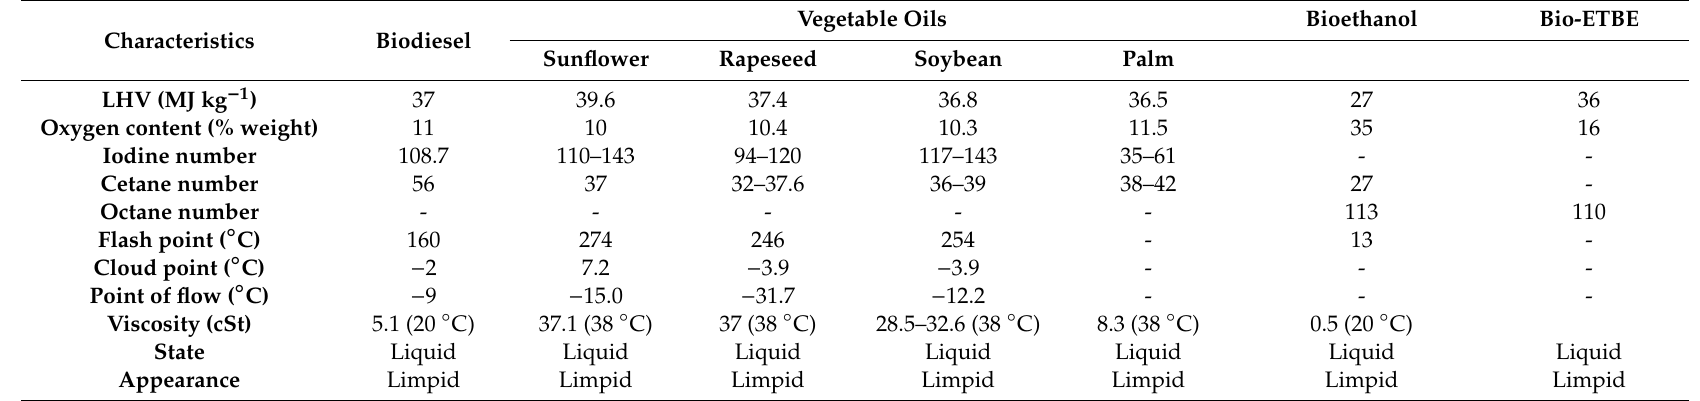
Table 1. Physico-chemical characteristics of first-generation biofuels (adapted from [11] LHV: lower heating value; Bio-ETBE: bioethyl tert-butyl ether.